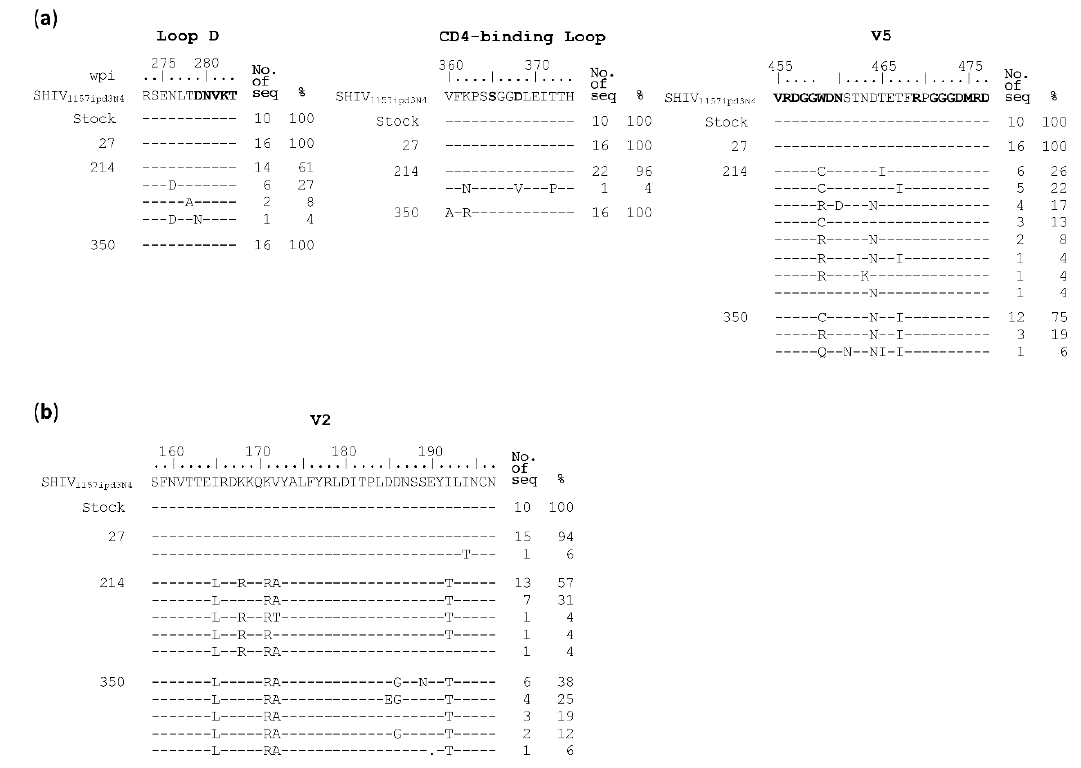
Figure 4. Identification of neutralization escape mutations in the env gene from longitudinal samples in G1015R. Amino acid sequences of ( a ) CD4 binding site (Loop D, CD4-binding loop and V5) and ( b ) V2 region from the viral stock and weeks 27, 214 and 350 post infection were compared to the SHIV 1157 reference sequence. The amino acids associated with CD4 binding are shown in bold letters. The amino acid positions are based on the HIV-1 HXB2 sequence.